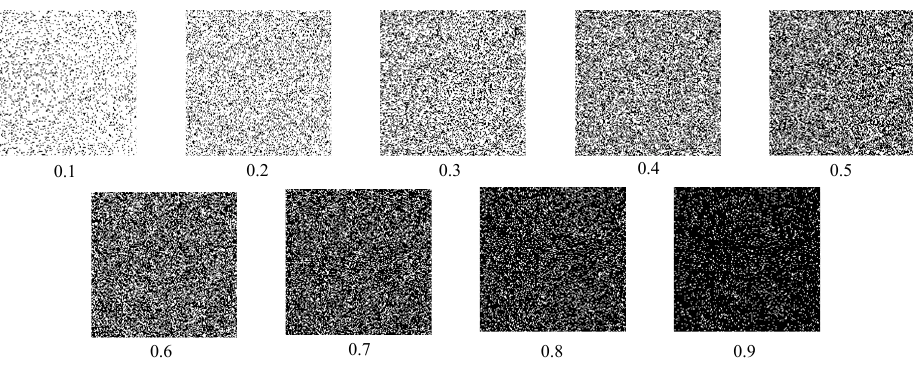
Figure 7. Crossing sections of noise images with di ff erent densities.